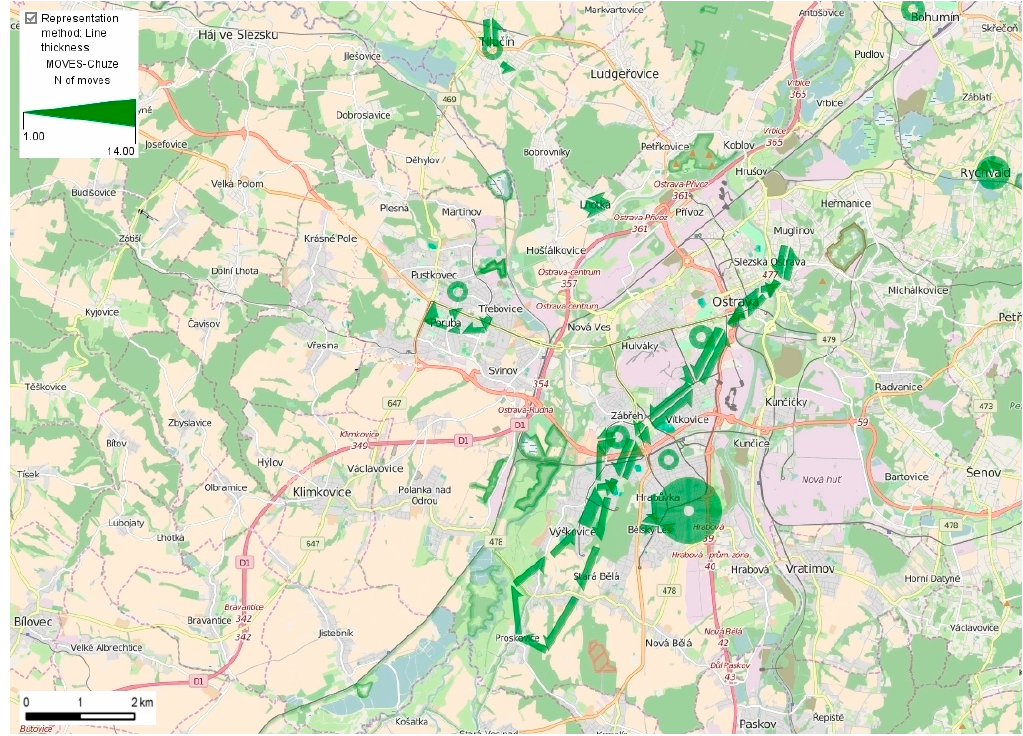
Figure 19. Dominant directions of movement in Ostrava according to walking.